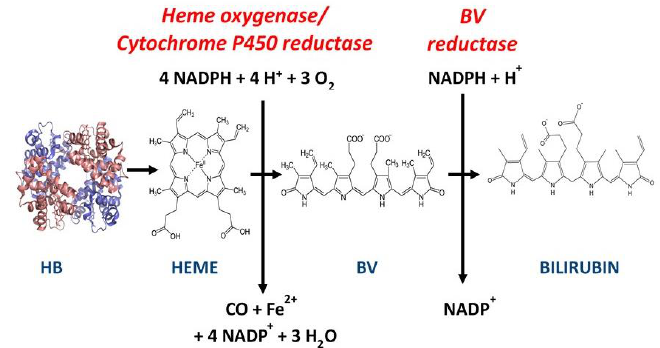
Figure 1. Red blood cells are degraded into hemoglobin (Hb) during cell turnover or damage. Hb further catabolizes to globin chains, which are broken into amino acids and heme. Heme oxygenase catabolizes the heme to yield ferrous iron, which will later travel to bone marrow to be used in new heme production, carbon monoxide, and biliverdin (Bv). Bv is then reduced to an unconjugated form of bilirubin (Bu). All of these degraded components can be present in inflammatory responses related to hemolysis, and each can maintain a unique contribution to the inflammatory reaction. The balanced reaction above is based on Hb with its heme iron in the ferrous state. The molecular image of Hb was generated using PyMol (Version 2, Schrodinger, LLC, Delano Scientific, San Carlos, CA, USA). Similar images of Heme, Bv, and Bu are available through ChemSpider online search and share chemistry, Royal Society of Chemistry, Cambridge,